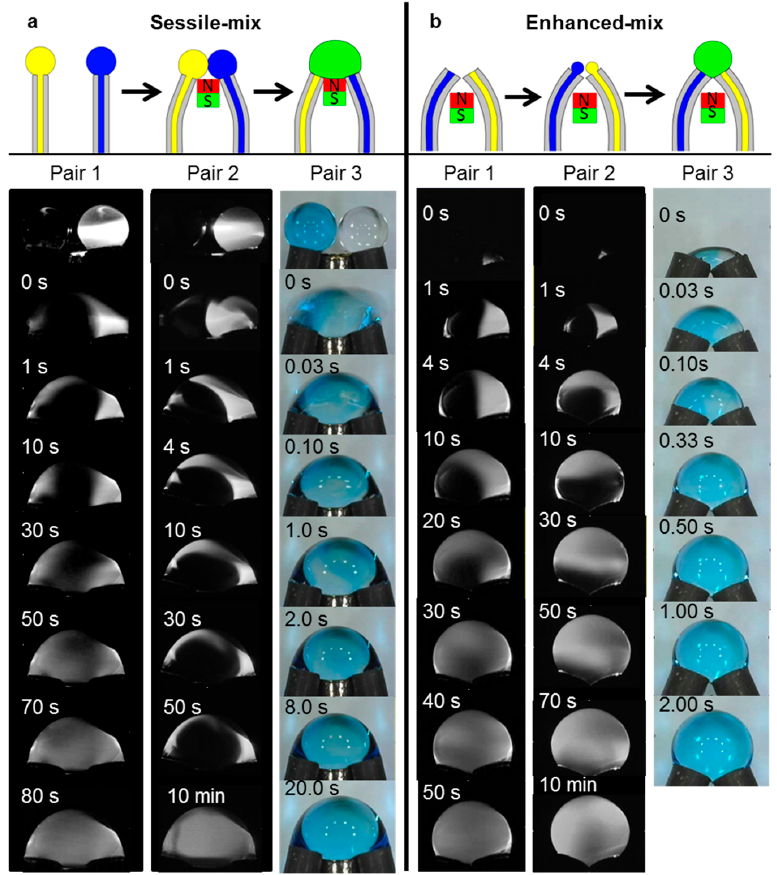
Figure 3. Mixing configurations. Laser-induced fluorescence (LIF) and color image sequences of ( a ) sessile-mix and ( b ) enhanced-mix of liquid pair 1: water and water with rhodamine, pair 2: water-glycerol and water-glycerol with rhodamine, and pair 3: water and water-ethanol with food colorant.